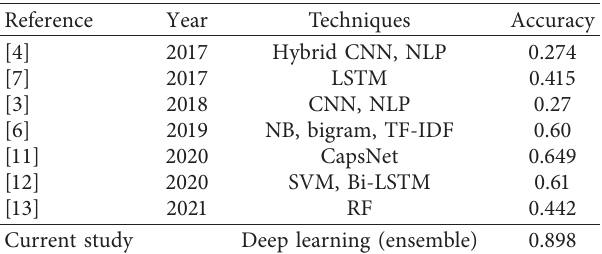
Figure 8: (a) Model testing loss and the number of epochs for Experiment 1. (b): Model testing accuracy and the number of epochs for Experiment 1. Table 4: Comparison of the proposed model with the baseline studies using LIAR